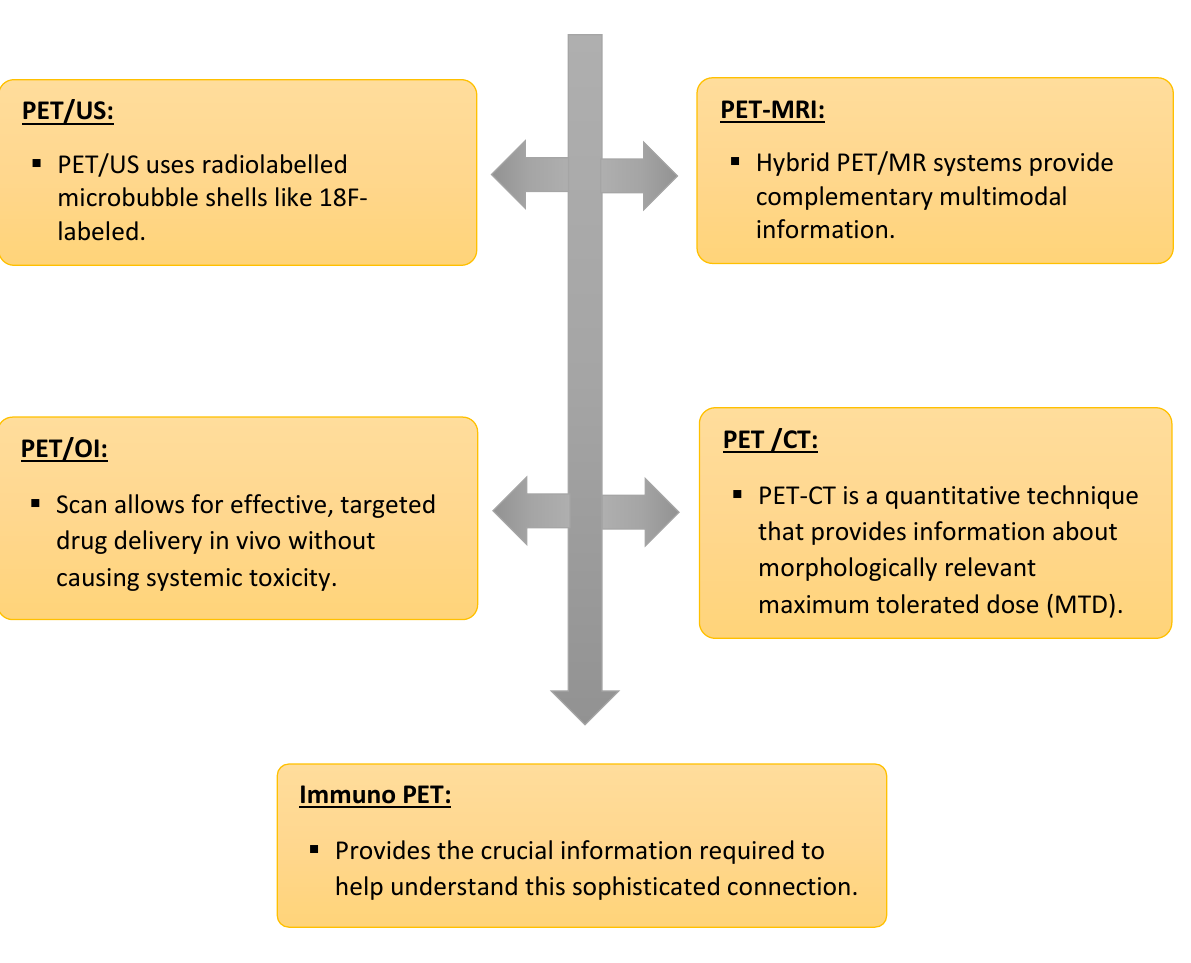
PET is the gold standard in clinical molecular imaging because it possesses the high sensitivity required for deep tissue penetration and visualization of most interactions between physiological targets and ligands.